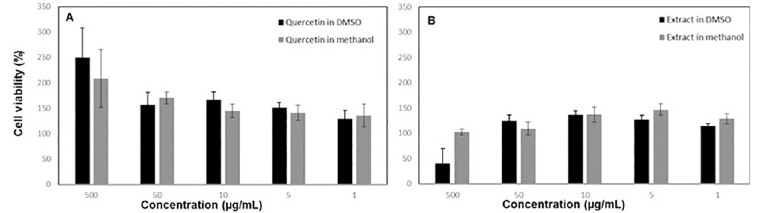
Fig 5. Cytotoxicity of quercetin (A) and Flavobacterium sp. (B) extracellular DMSO extract and methanol on ECV-304 cell lines ( � P <